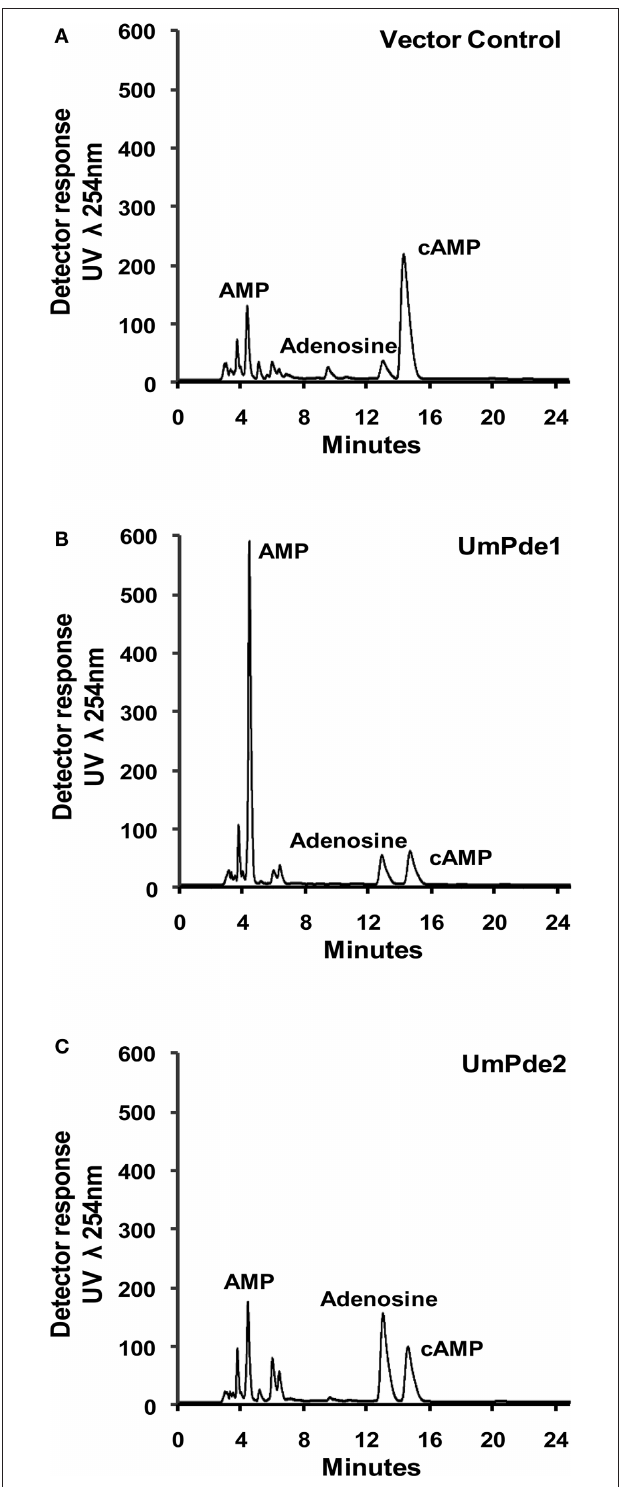
Figure 3 | Sample rP-HPLC chromatograms of (A) empty vector sample with a major peak for cAMP; (B) UmPde1 expressed sample showing one major product peak for AMP; (C) UmPde2 expressed sample showing two major product peaks, for AMP and for Adenosine. AMP, adenosine monophosphate, cAMP, cyclic AMP.